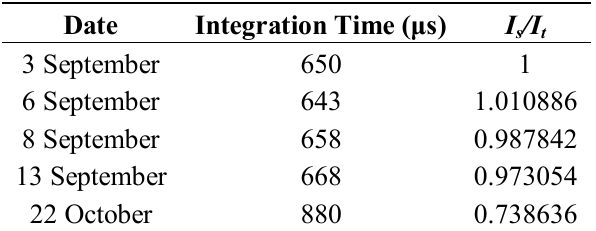
Table 3. Normalization coefficients of integration time of Dunhuang images.